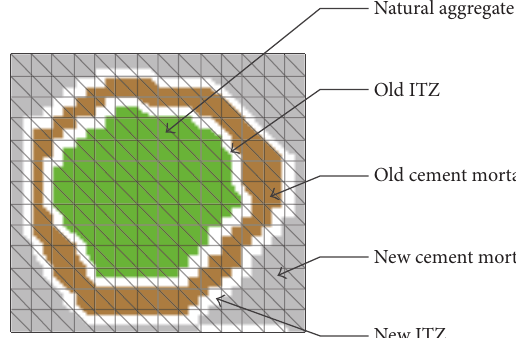
Figure 5: Attribute interval recognition of convex polygon recycled coarse